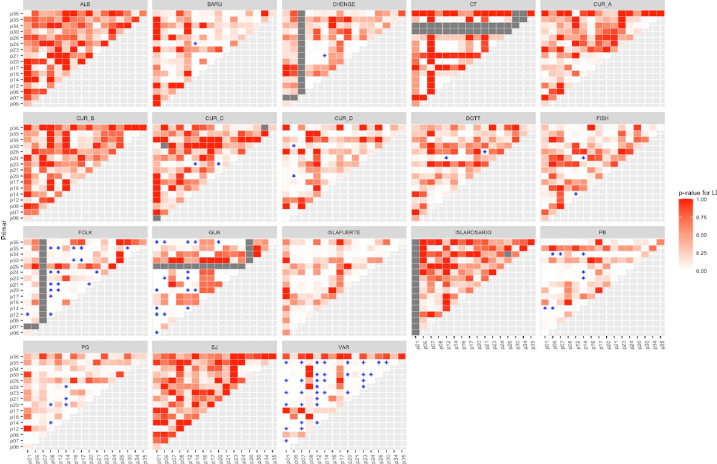
Fig 1. Linkage disequilibrium per locality. Blue stars show the p- values < 0.05 after the Bonferroni correction. Clear tones (white) are the p-values < 0.05 without the Bonferroni correction. Grey colours show the missing or not enough data for the loci ( < than four samples per